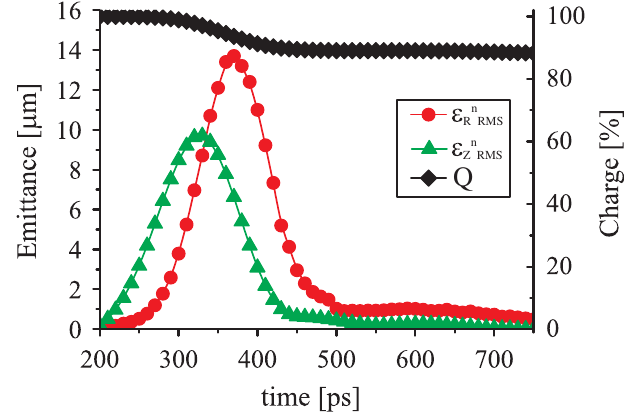
FIG. 3. (Color) Time evolution of the energy ( E ), energy spread ), charge ( Q ), and bunch length ( (cid:4) ( (cid:4) E denotes the end of the plasma in the accelerator scheme while the second dotted line (C) indicates the end of the plasma in the new compression scheme.